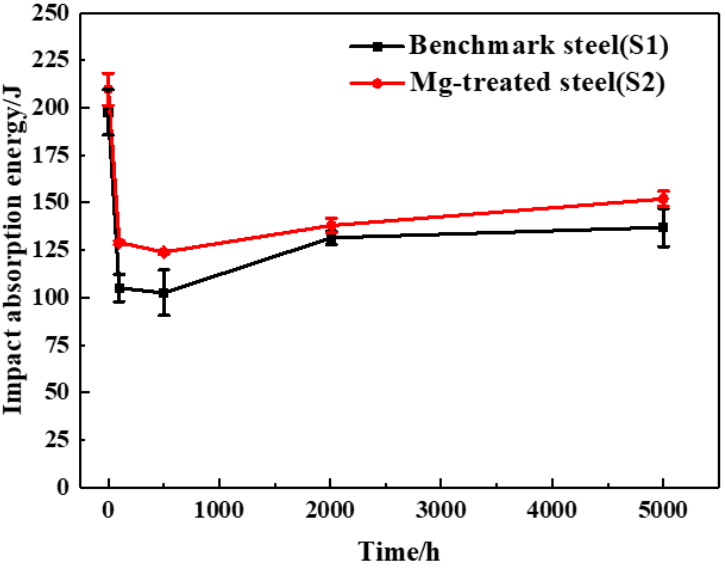
Figure 2. Charpy impact energies of S2 and S3 samples at room temperature after aging different times. ent